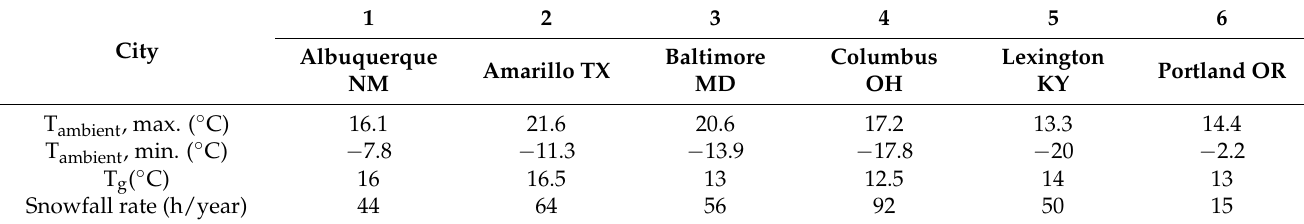
Table 3. Summary of weather data in different modeled